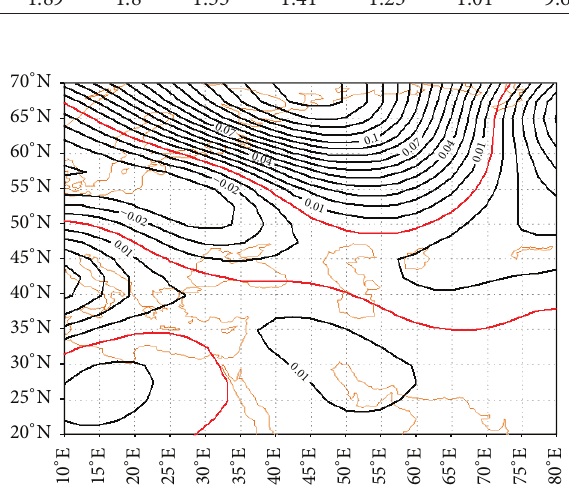
Figure 2: The first component of 500 HPa geopotential height level data.